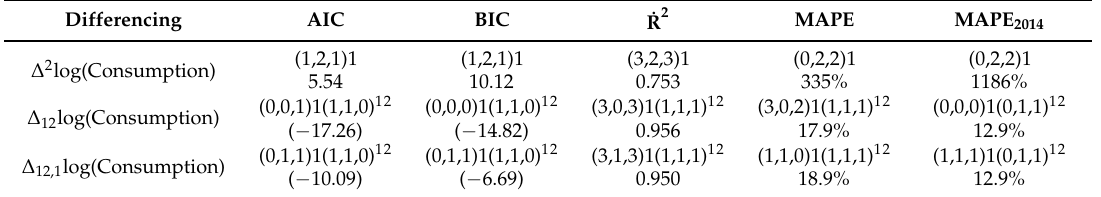
Table 6. Best results of error and forecasting measurement for ARIMA and SARIMA.